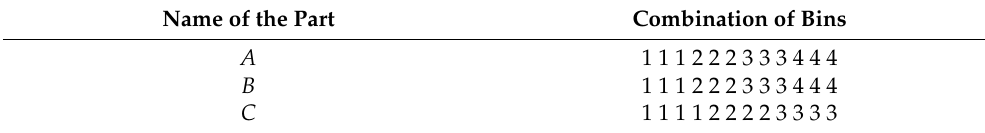
Table 6. Construction of combination of bins.